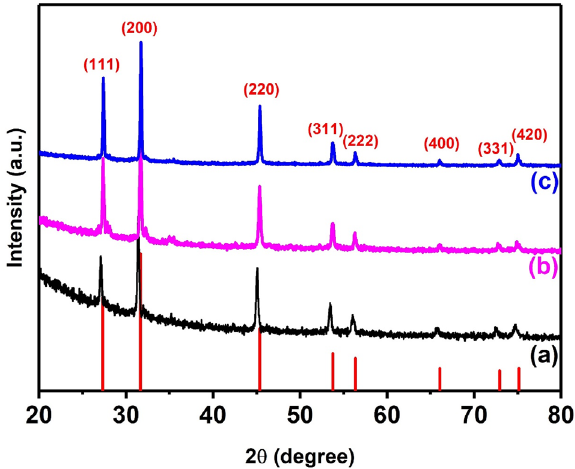
Figure 3. XRD patterns of AgSbS 2 powders synthesised at various temperatures ( a ) 400 °C ( b ) 450 °C, and ( c ) 500 °C for 1 h under nitrogen. The red sticks correspond to the standard powder diffraction pattern of cubic